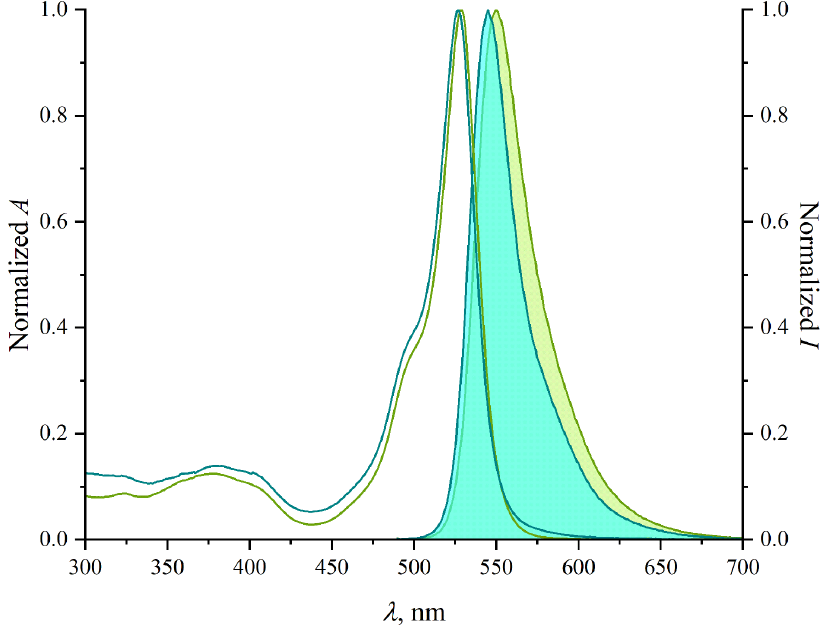
Figure 1. Absorption (unfilled area plot) and emission (filled area plot) spectra of COOH-Ph- BODIPY (blue) and NHS-Ph-BODIPY (green) in DMSO. Table 1. Photophysical characteristics of COOH-Ph-BODIPY and NHS-Ph-BODIPY in organic solvents.